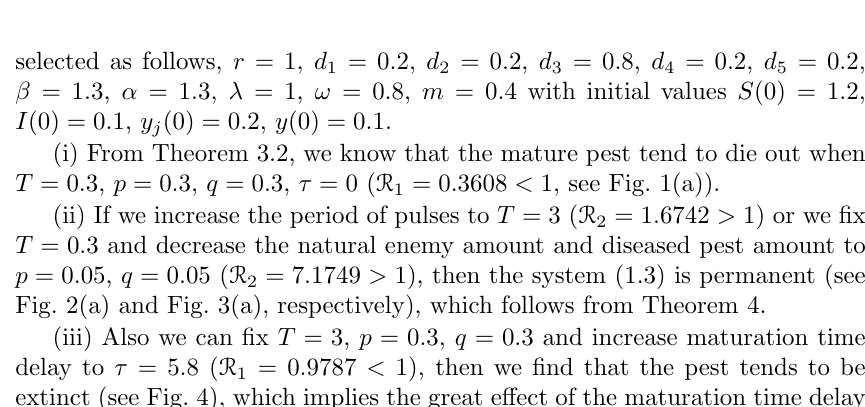
selected as follows, r = 1, d 1 = 0 . 2, d 2 = 0 . 2, d 3 = 0 . 8, d 4 = 0 . 2, d 5 = 0 . 2, β = 1 . 3, α = 1 . 3, λ = 1, ω = 0 . 8, m = 0 . 4 with initial values S (0) = 1 .